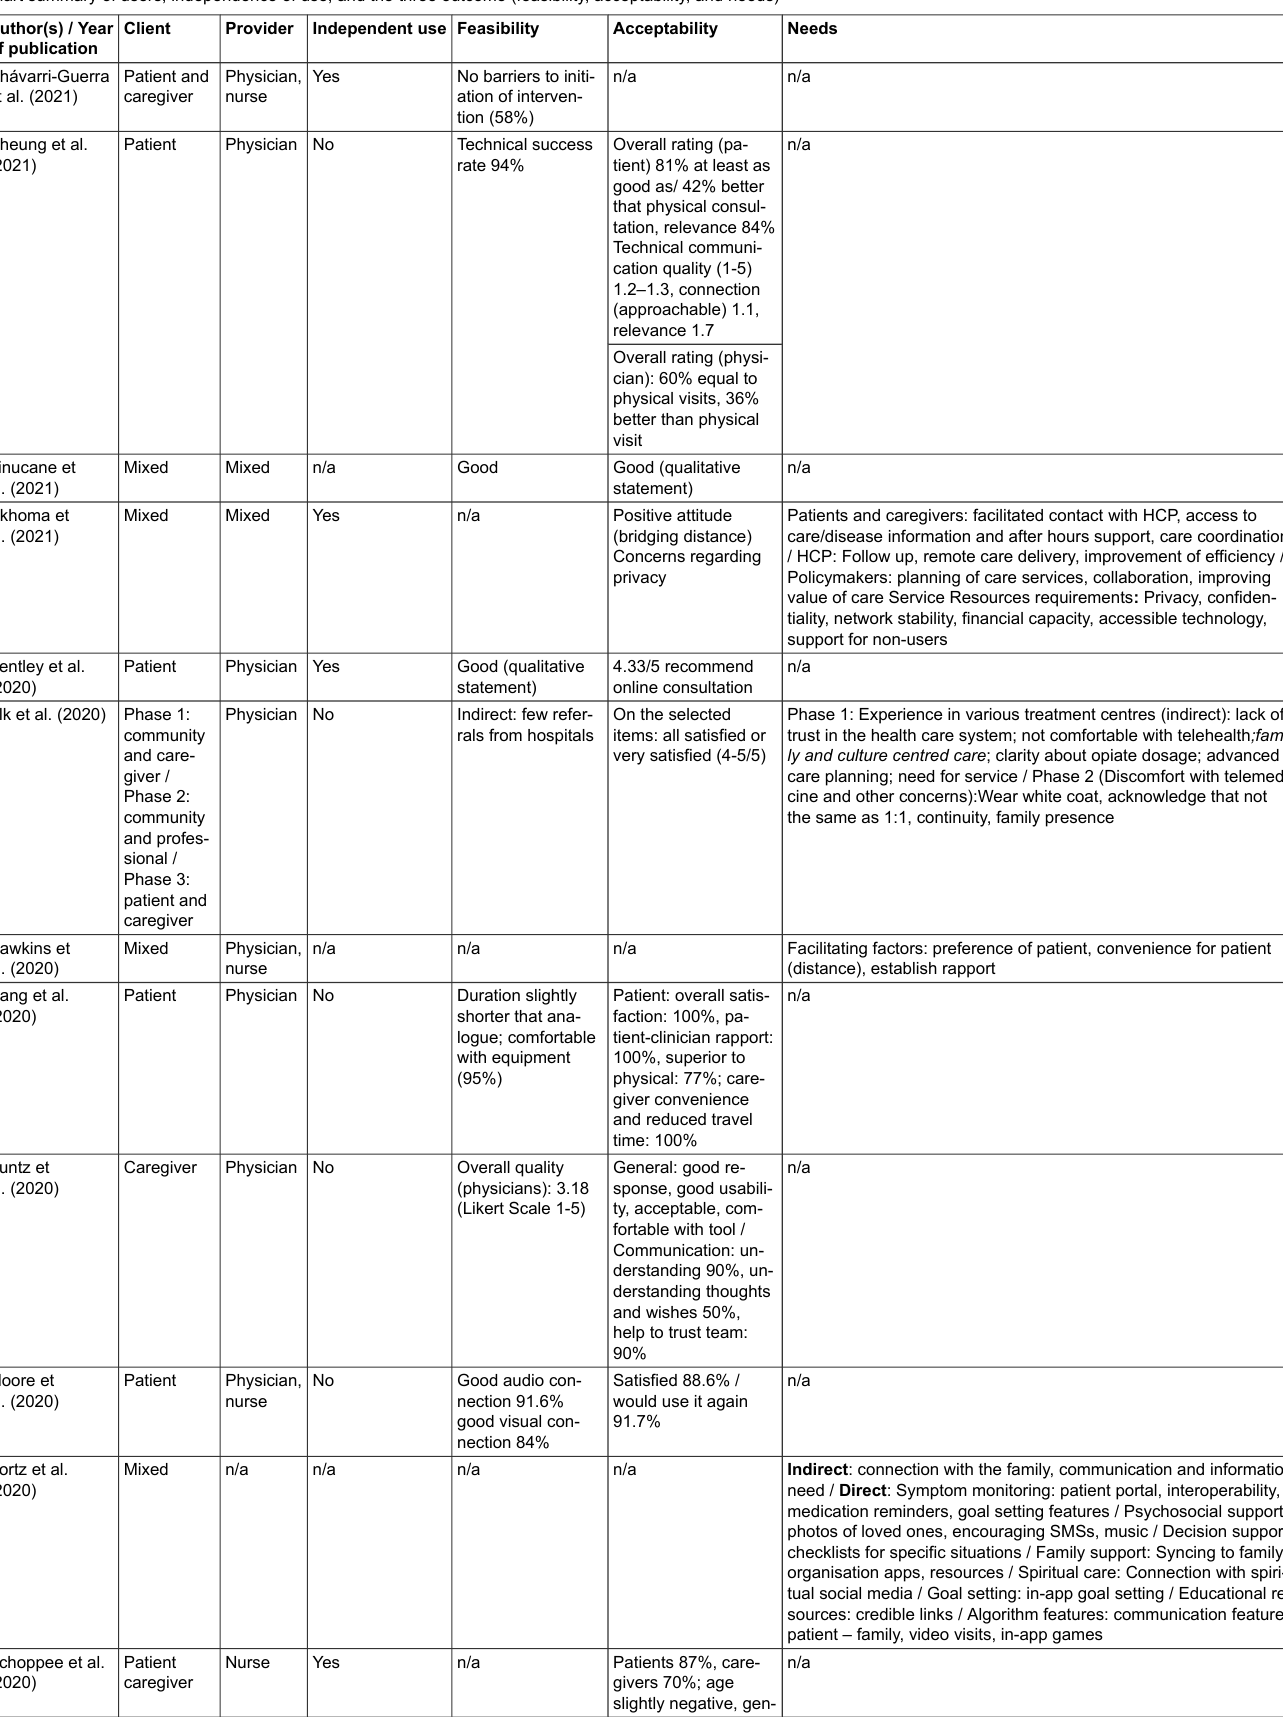
Table S2: Chart summary of users, independence of use, and the three outcome (feasibility, acceptability, and